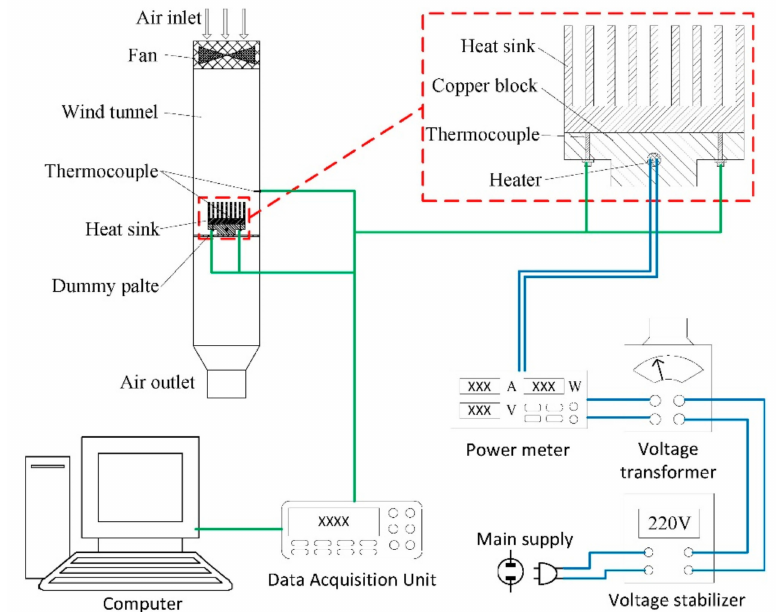
Figure 3. Heat dissipation performance test system with wind